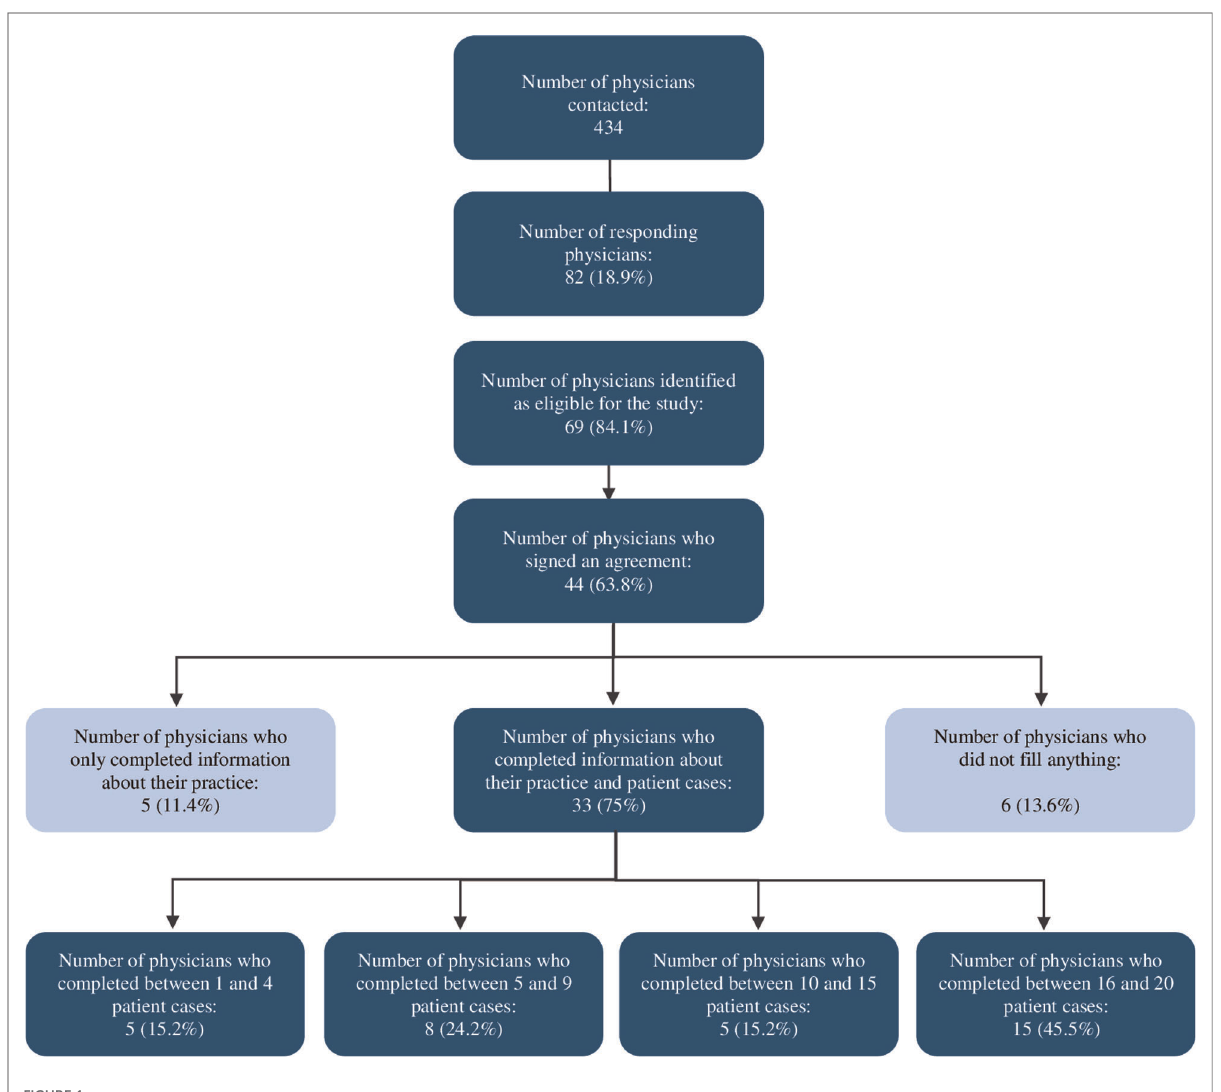
FIGURE 1 Study fl ow chart for physician recruitment and participation in the MaDo